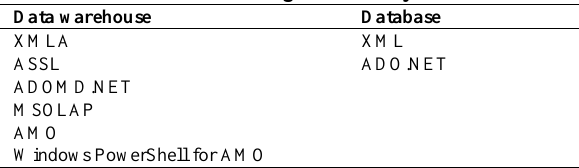
Table 5. Programmability.